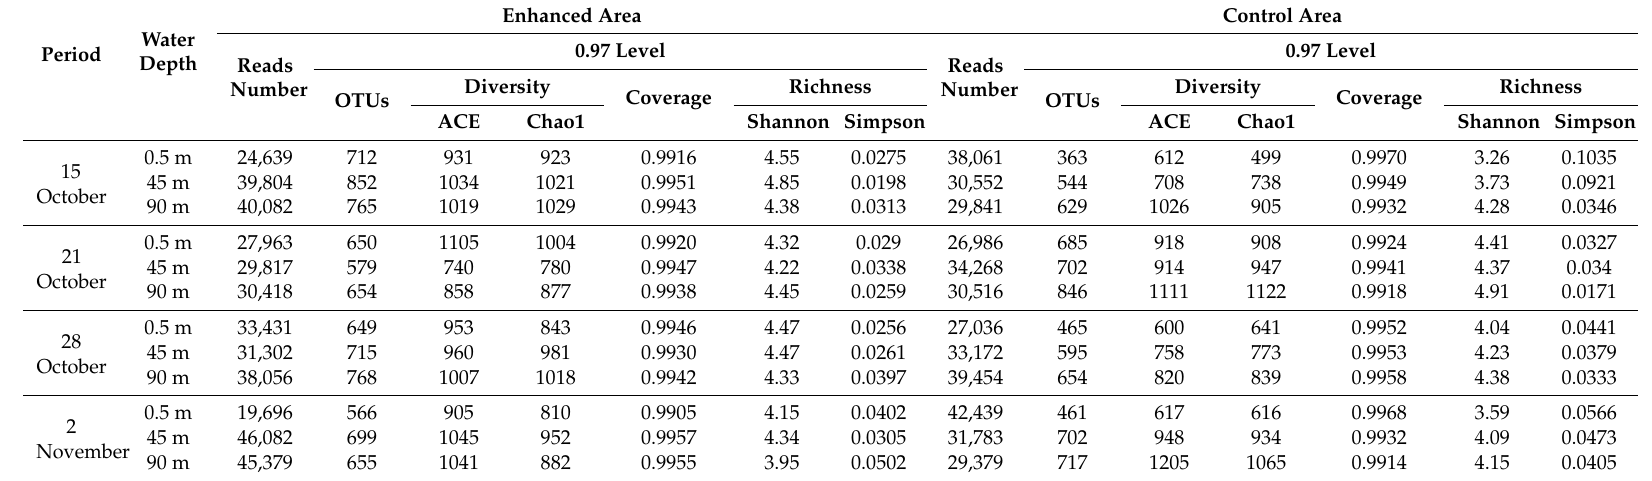
Table 2. Spatial and temporal distribution of the microbial community diversity and richness estimators in the enhanced and control areas